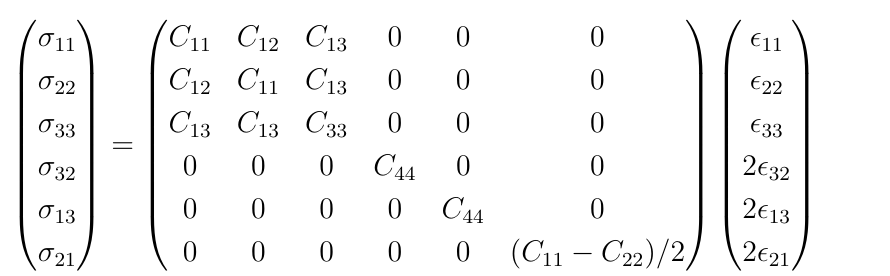
Elastic constants of graphite [20]: A = hC 11 , (cid:23) = C 12 =C 11 , C = h ( C 11 (cid:0) C 2 =C 11 ) , g = h ( C 11 (cid:0) C 22 ) = 2 with h the 12 graphite interlayer distance (0.335 nm)